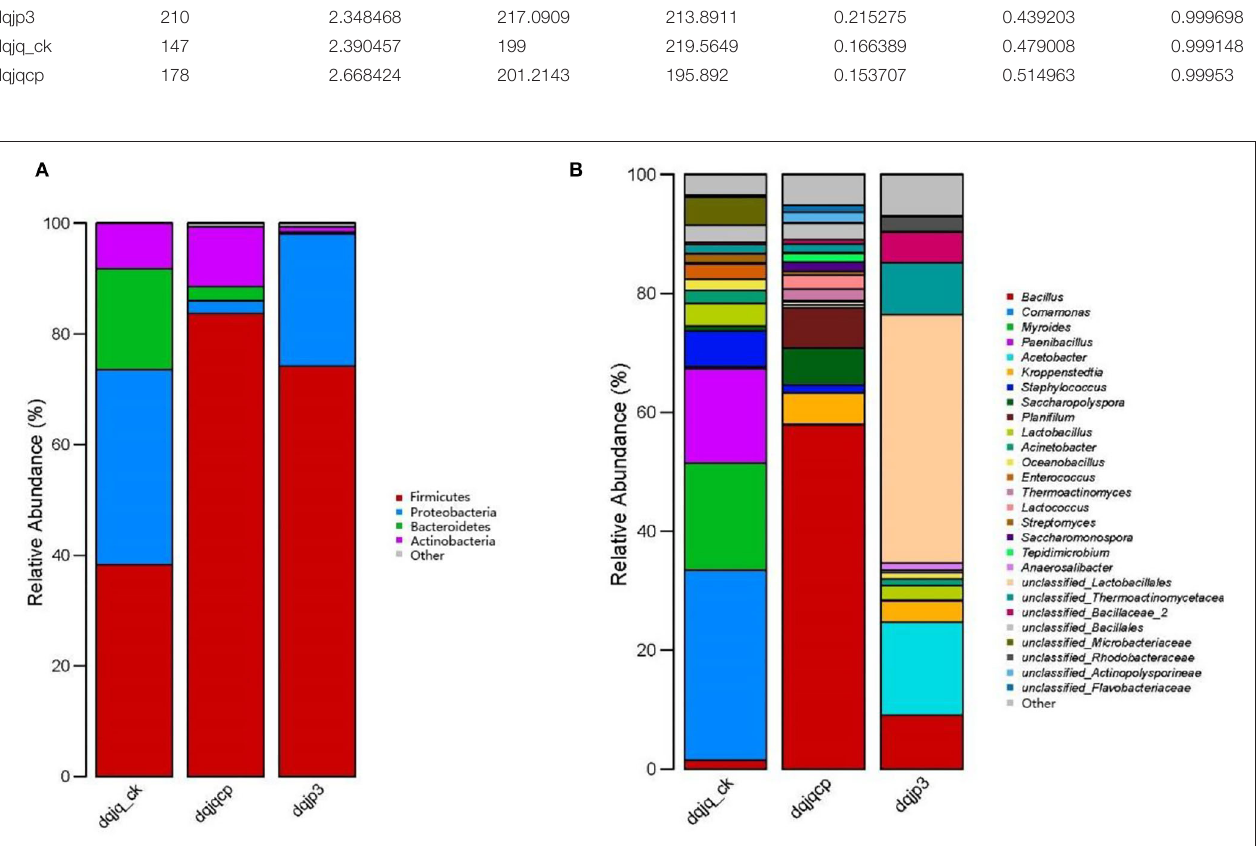
FIGURE 2 | Taxonomic classification of bacterial reads retrieved from three samples at phylum and genus levels using RDP classifier. (A) Phylum level. (B) Genus